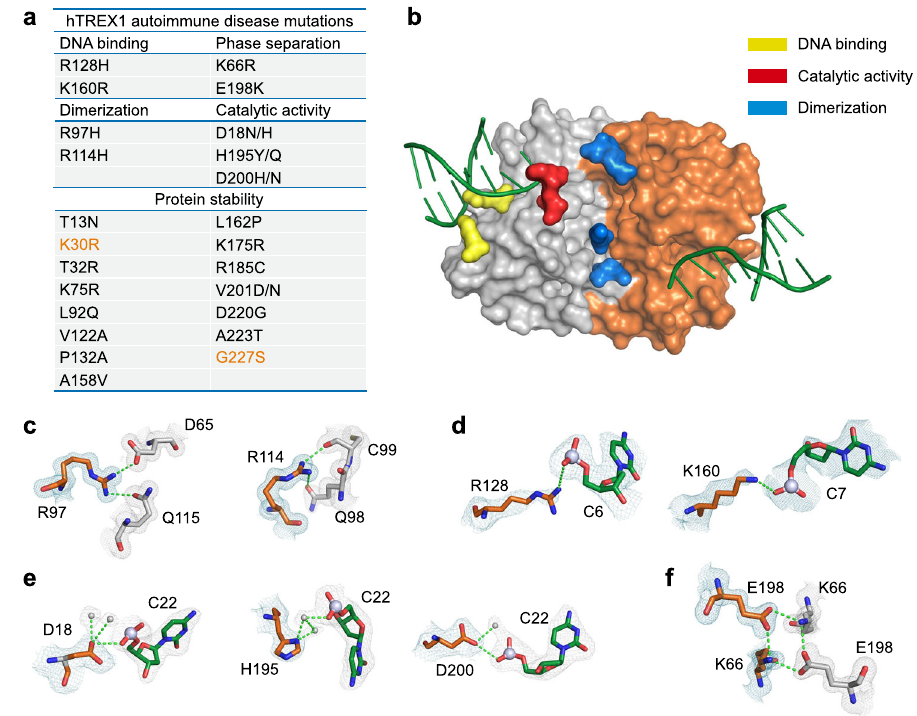
Fig. 4 | Structural basis of human TREX1 autoimmune disease mutations. a Autoimmune disease-associated mutations in TREX1, and the structural role of each residues predicted by the structures of hTREX1 apo and hTREX1 – DNA com- plex. Residues that are not conserved between human and mouse TREX1 are highlighted in orange. b Highlights of the autoimmune disease-associated muta- tions in hTREX1 on the hTREX1 – DNA complex. c – f Structural basis of TREX1